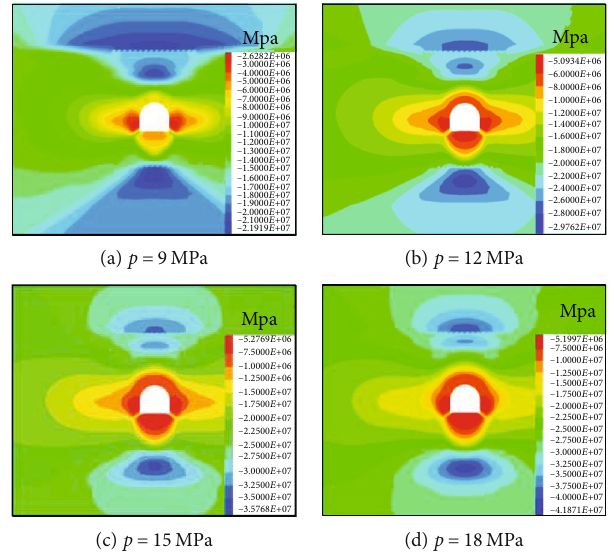
Figure 8: Principal stress di ff erence of the surrounding